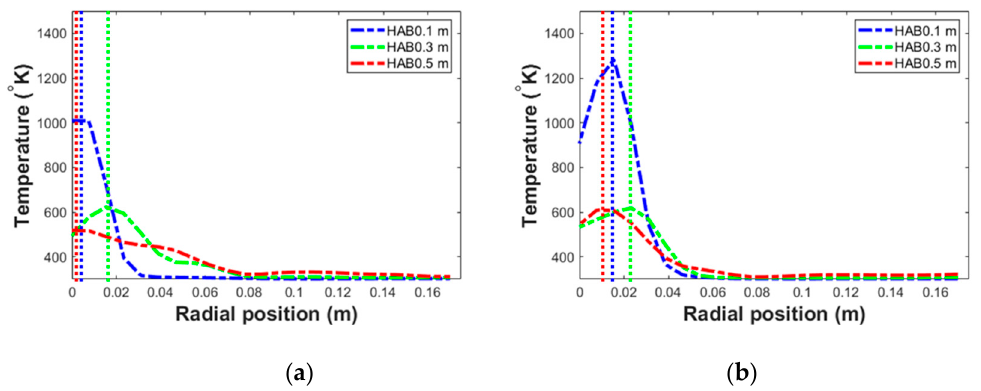
Figure 6. Plot of temperature along with the radial direction at three monitoring HABs: 01 slit case ( a ) and 02 slit case ( b ).